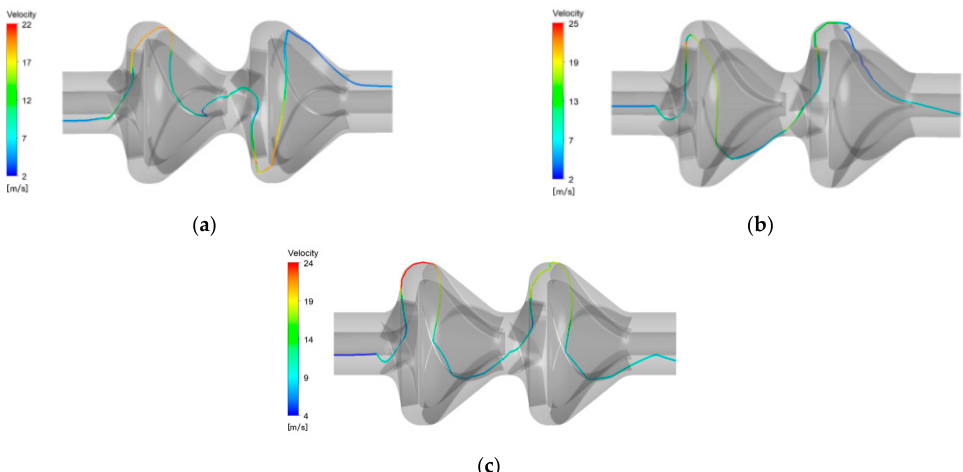
Figure 13. Single particle movement trajectory in the calculation domain: ( a ) 1400 kg/m 3 ; ( b ) 1900 kg/m 3 ; ( c ) 2800 kg/m 3 .